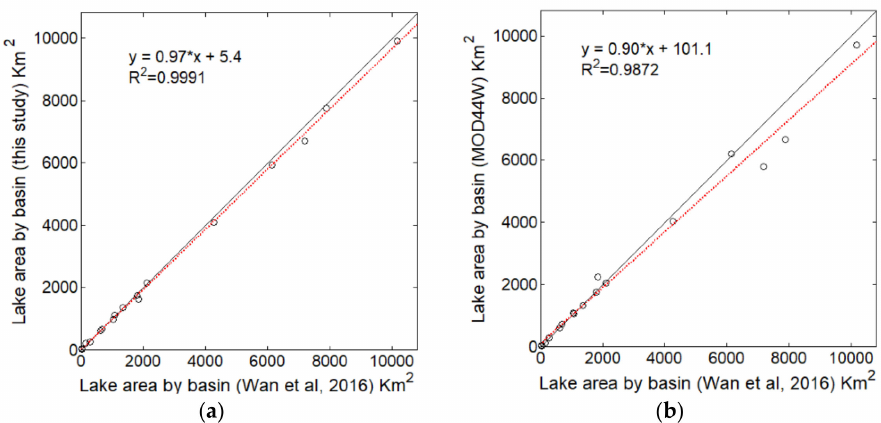
Figure 7. Scatter plots of the lake area categorized by basin derived from ( a ) this study versus the reference TP lake data set and ( b ) MOD44W versus the TP lake data set. The dashed line refers to the linear